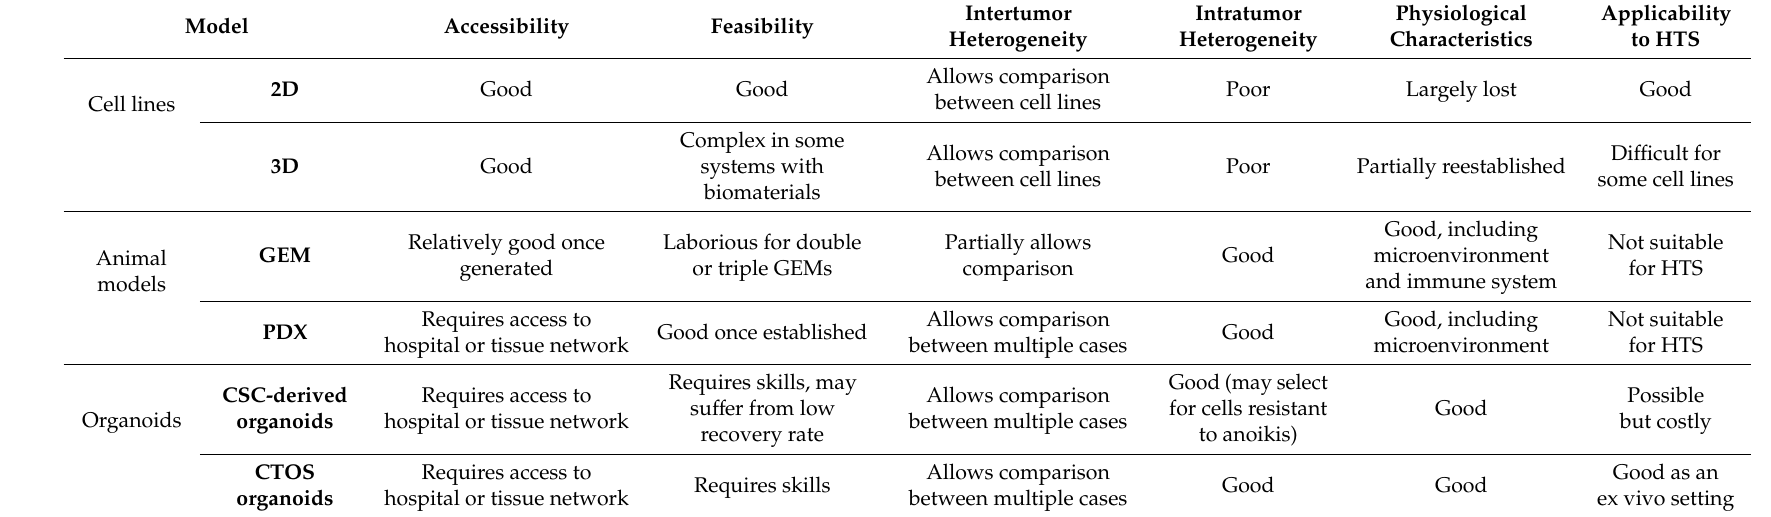
Table 1. Pros and cons of disease